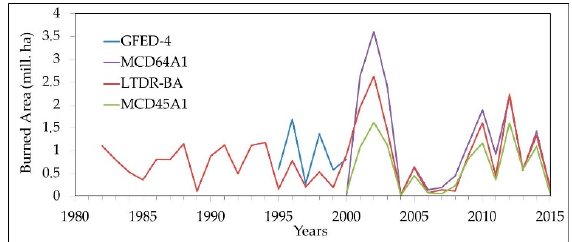
Figure 5. 1982–2015 annual Northeastern Siberia BA from MCD45A1, MCD64A1, GFED-4, and LTDR BA products .